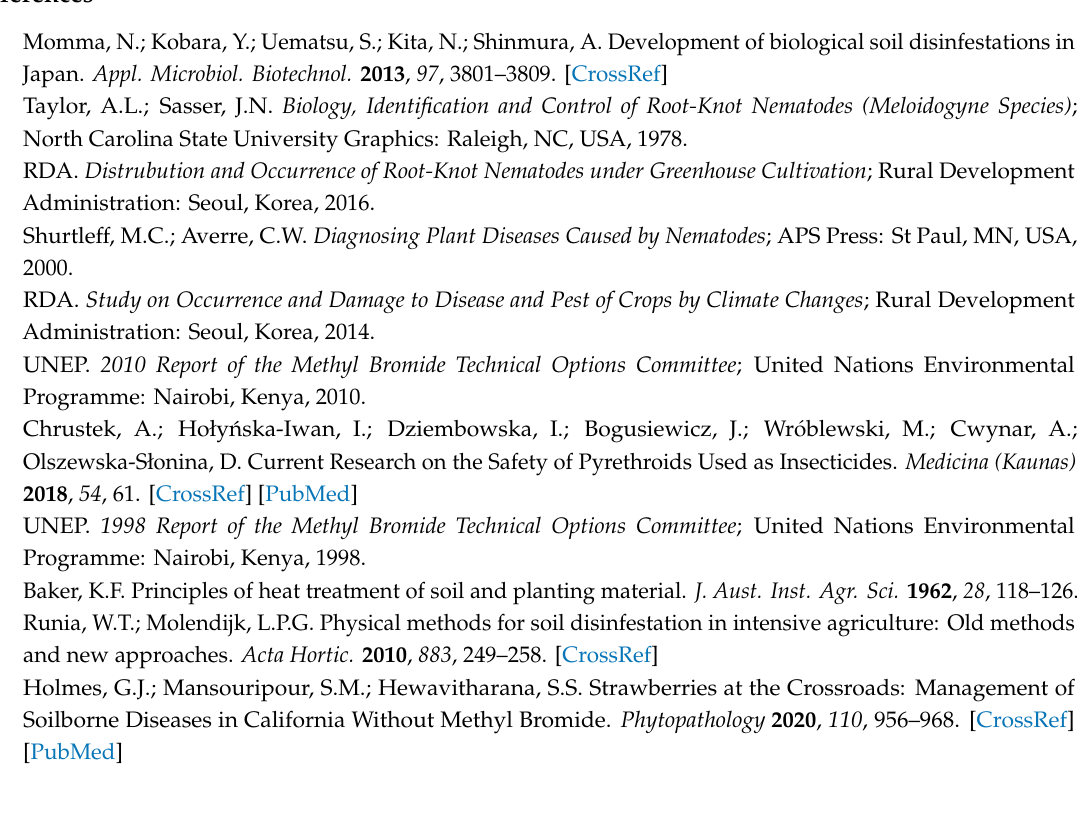
Figure S1: Flow chart of the optimization